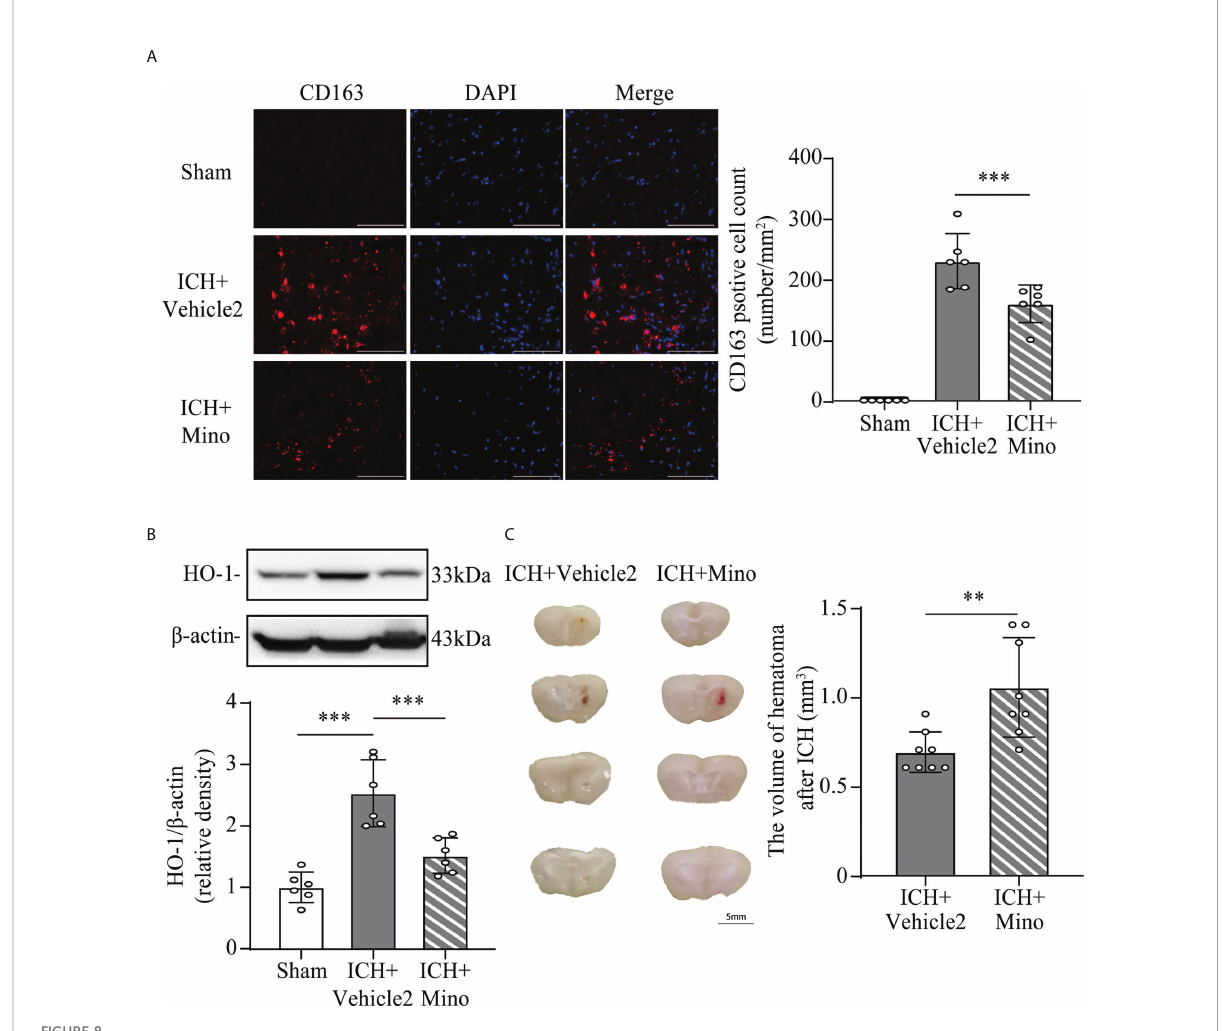
FIGURE 8 The effect of minocycline on the CD163/HO-1 pathway and hematoma resolution after ICH. (A) Representative immuno fl uorescent image and quantitative analysis of CD163 positive cell. ***P <0.001 by way of one-way ANOVA. Scale bar = 100 m m. n = 6. (B) Representative western blotting images and quantitative analysis of HO-1. n = 6. ***P <0.001 by Brown-Forsythe and Welch ’ s ANOVA. (C) Representative brain section and quantitative analysis of hematoma volume. n = 8. **P <0.01 by Mann – Whitney test. Data are represented as mean ±